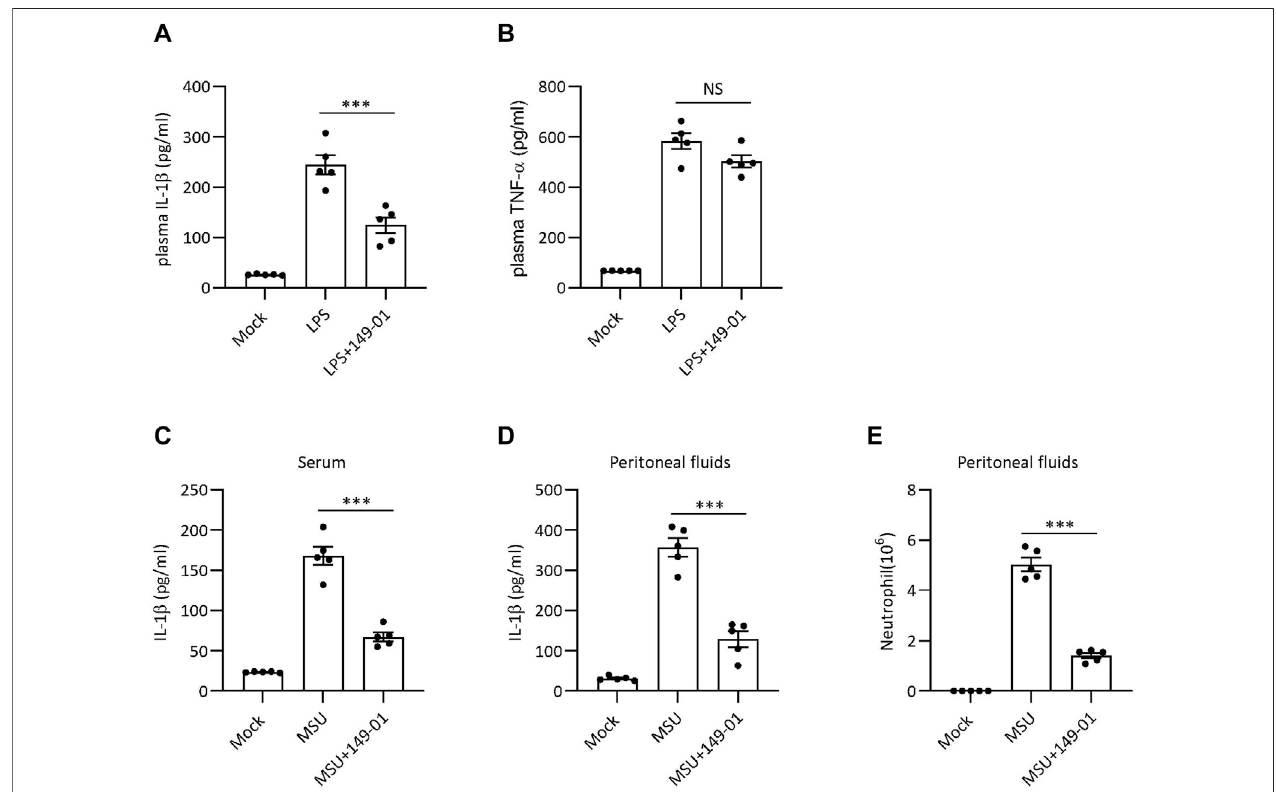
FIGURE 6 | 149-01 alleviates LPS-induced systemic in fl ammation and MSU-induced peritonitis in mice. (A,B) Serum IL-1 β (A) and TNF- α (B) levels in mice intraperitoneallyinjectedwith149-01(5 mg/kg)orvehiclebeforechallengewithLPS(20 mg/kg)weremeasuredbyELISA. (C – E) Micewereintraperitoneallyinjectedwith 149-01(5 mg/kg)orvehiclebeforechallengewithMSU(1 mg/mouse).IL-1 β intheserum (C) orperitonealcavity (D) weremeasuredbyELISA. (E) Neutrophilnumbersin the peritoneal cavity were determined by FACS. Data are expressed as mean ± s. e.m ( n = 5). One-way ANOVA was applied to calculate statistical signi fi cance: *** p < .001, NS, not signi fi